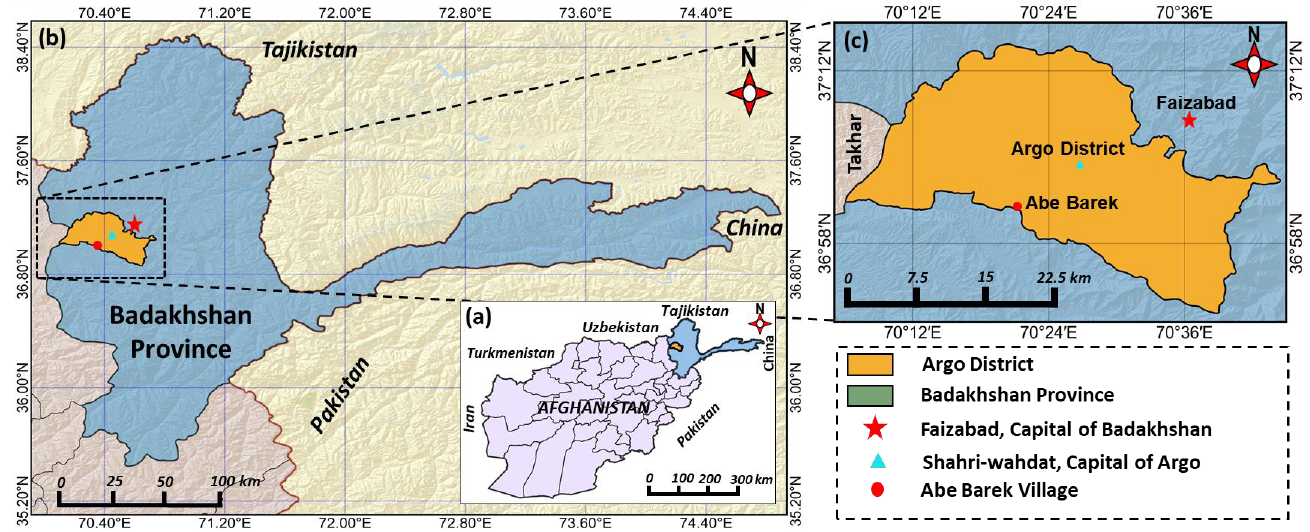
Figure 1. Location of the study area. ( a ) Afghanistan, study area, and borders with neighboring countries, ( b ) Badakhshan province, ( c ) Argo district, and Abe Barek village.